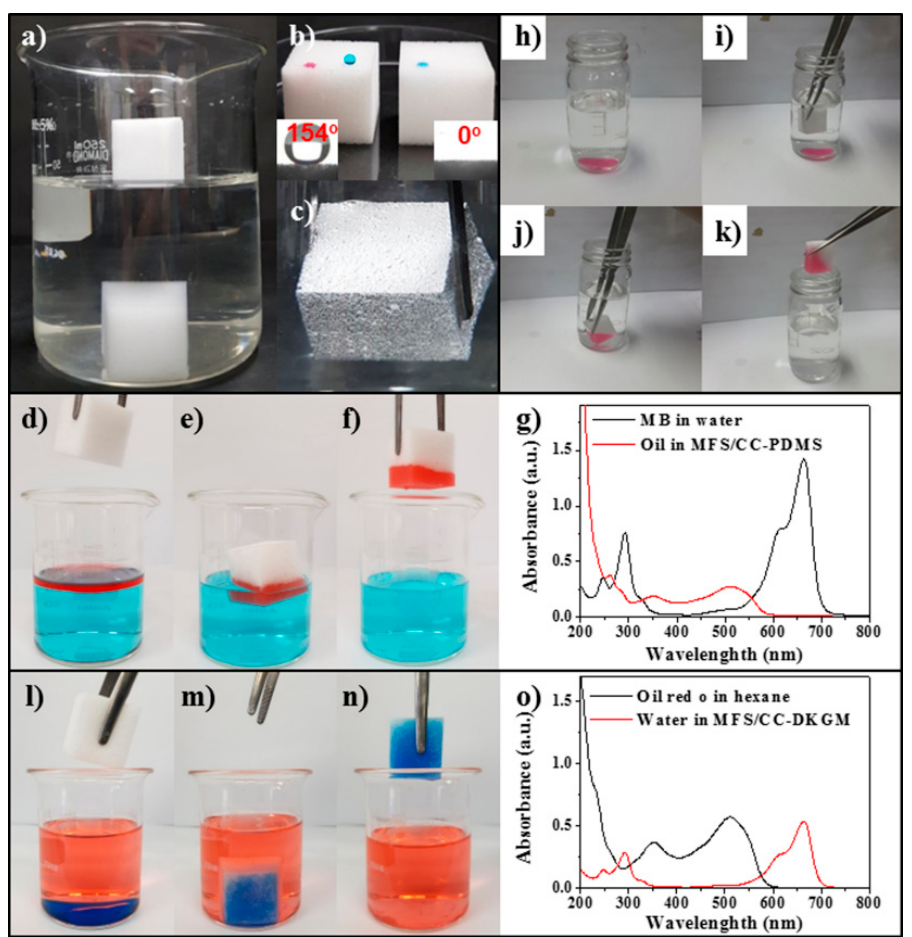
Figure 4. ( a ) Image showing the MFS/CC-DKGM (submerged under water, bottom of beaker) and MFS/CC-PDMS (floating on top of the water, top of beaker). ( b ) The image on the right side of the larger image on the left shows oil and water droplets on the MFS/CC-PDMS and (right) water droplets on the MFS/CC-DKGM. The insets show the WCAs on the (left) MFS/CC-PDMS and (right) MFS/CC-DKGM. ( c ) Image of the MFS/CC-PDMS immersed in water by an external force. ( d – f ) Images showing spontaneous oil absorption of the MFS/CC-PDMS in a hexane/water mixture. ( g ) UV-vis absorption spectrum (red line) of oil red O solution obtaining from the MFS/CC-PDMS. (black line) For comparison, UV-vis absorption spectrum of MB solution was provided. ( h – k ) Images showing the chloroform absorption and separation processes from the water/chloroform mixture using the MFS/CC-PDMS. ( l – n ) Images showing the water absorption and separation processes from the hexane/water mixture, using the MFS/CC-DKGM. ( o ) The red line represents the UV-vis absorption spectrum of MB solution obtained from the MFS/CC-DKGM. For comparison, the black line represents UV-vis absorption spectrum of oil red O solution was provided.